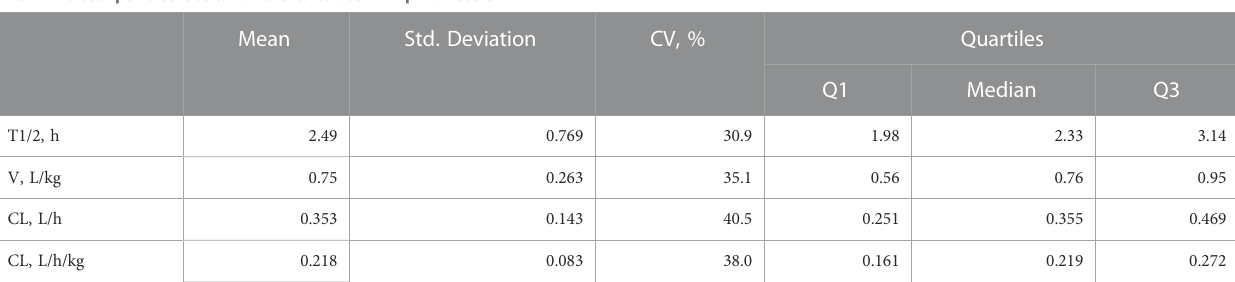
TABLE 2 Descriptive statistics for the calculated PK parameters. Mean Std.